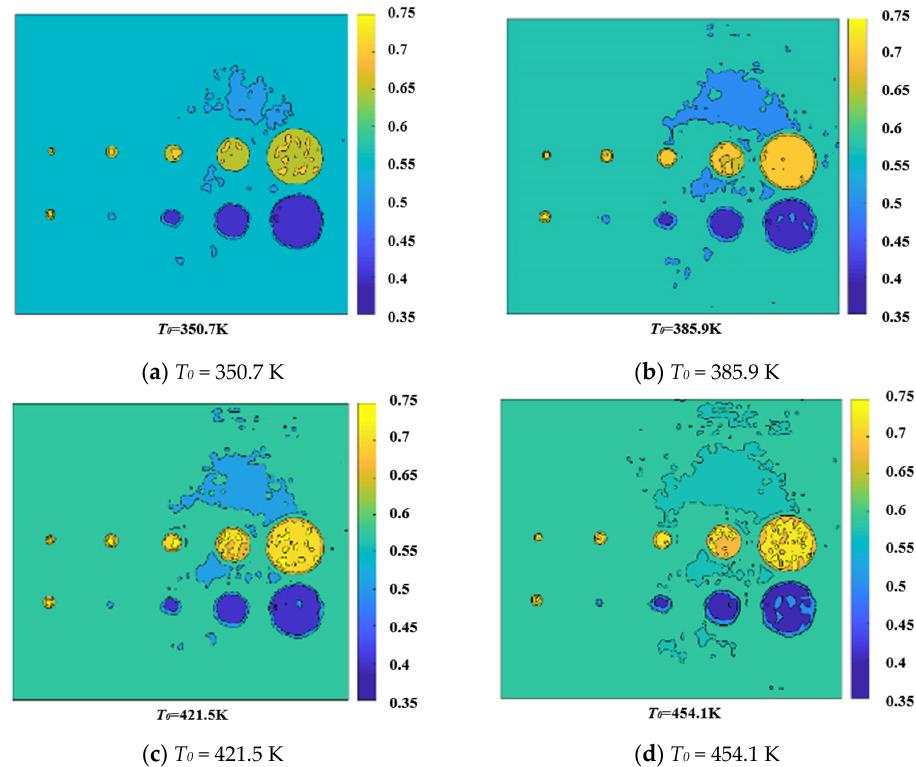
Figure 5. Calculation results of damage emissivity field for shedding and wear. Points A, B, C, and D are selected from the intact coating, the 18 mm wear and shed- ding damage, and the 2 mm shedding damage, respectively, to analyze the emissivity changes.